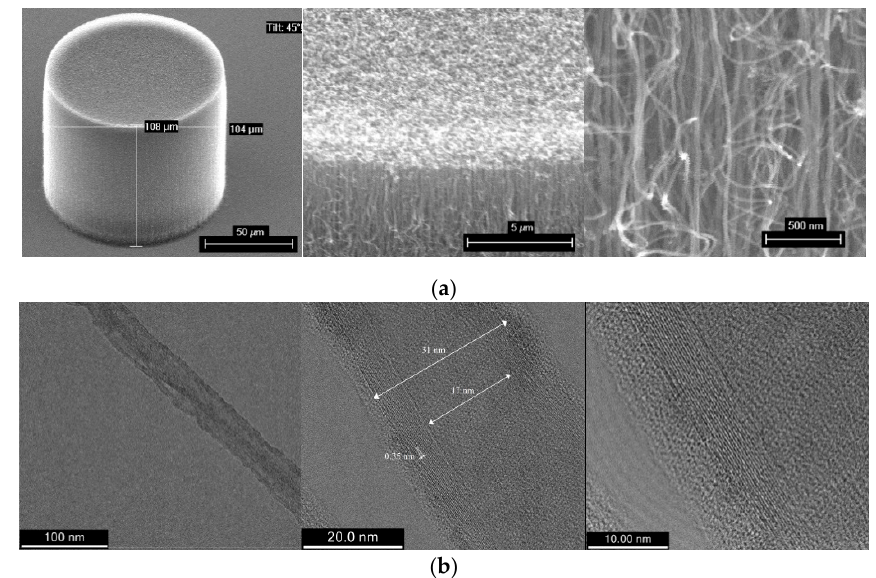
Figure 2. ( a ) Scanning electron microscopy (SEM) images of pristine vertically aligned (VA)-MWCNT pillar and ( b ) transmission electron microscopy (TEM) images of pristine MWCNT, at different magnifications.